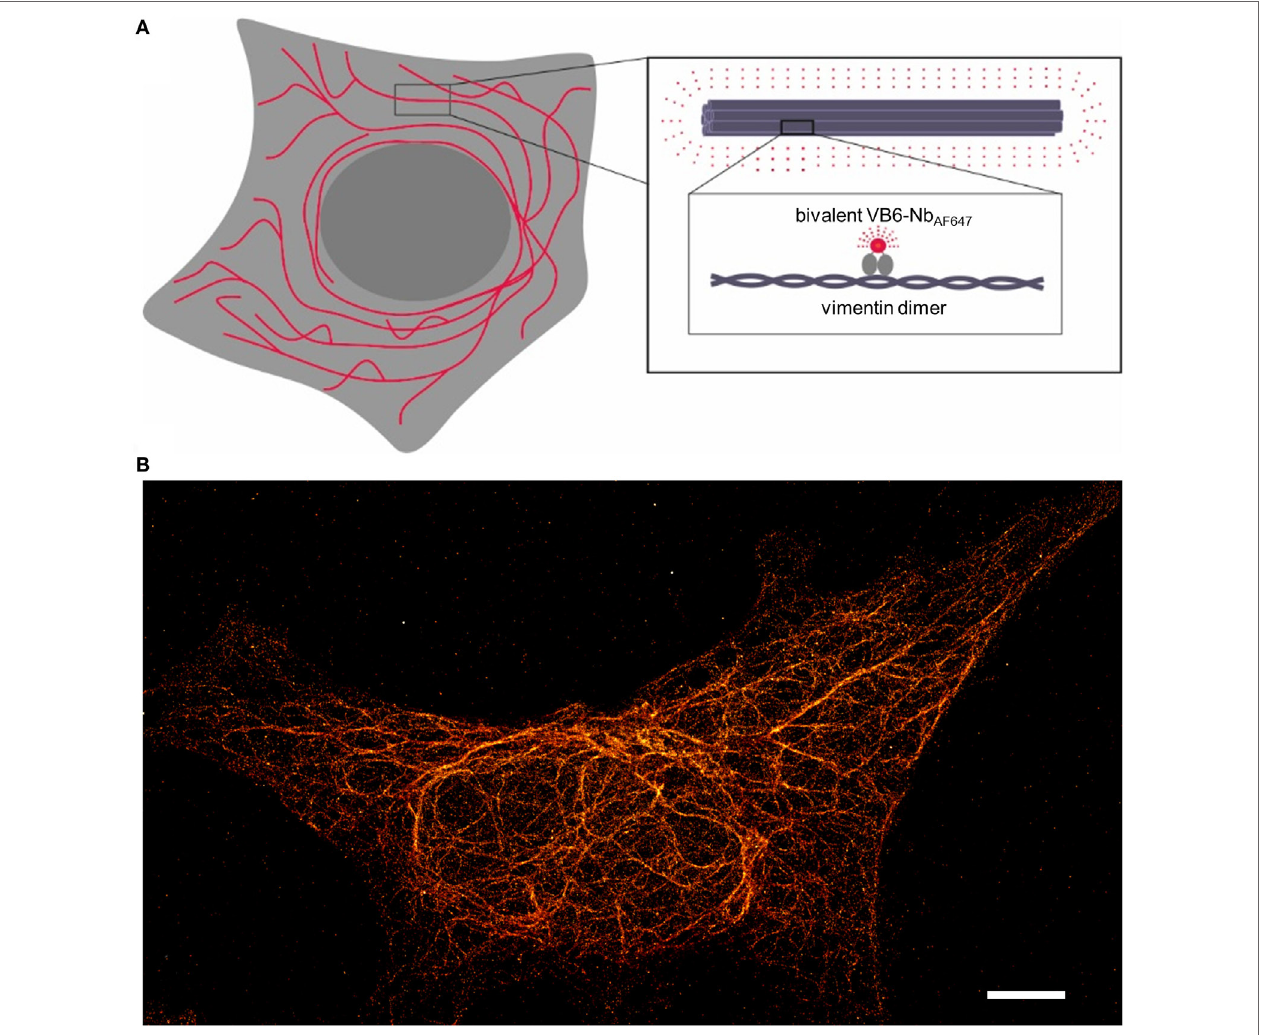
FiGURe 2 | Illustration of the nanobody-based labeling strategy for stochastic optical reconstruction microscopy (STORM) of the native vimentin network. (A) Schematical depiction of the bivalent VB6 (bivVB6)-Nb-labeled vimentin network. The boxed regions outline the organization of individual vimentin molecules into larger fibers and highlight the detection of dimeric vimentin with the fluorescently labeled bivalent VB6-Nb (bivVB6-Nb AF647 ). (B) Representative STORM image of a HeLa cell, stained with the bivVB6-Nb AF647 . Scale bar, 5